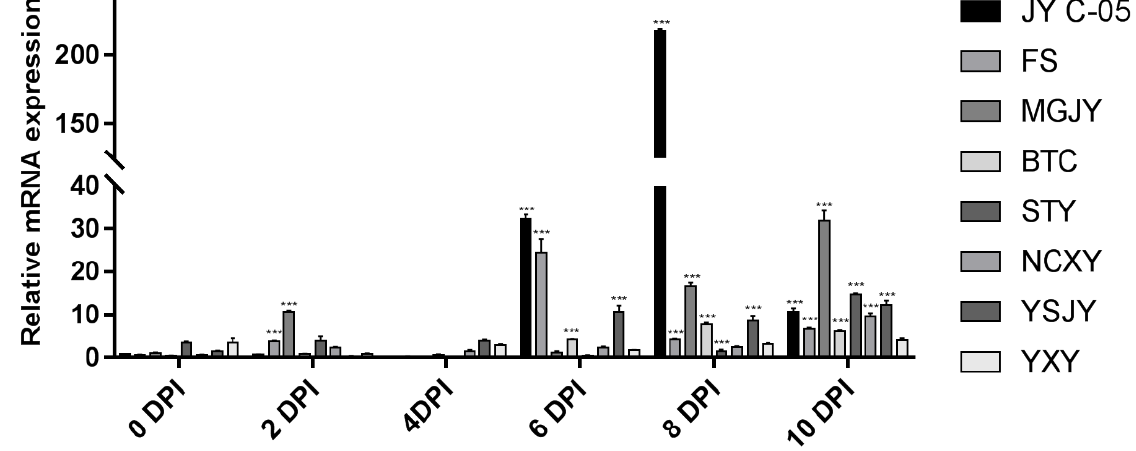
Figure 2. Relative expression levels of BAK1 . *** indicate significant differences ( p < 0.05, respec- tively). BTC: ‘Bingtang’ sweet orange; STY: Pomelo; NCXY: Nanchuan citron; YSJY: Wild citron; YXY: Round citron; MGJY: American citron; FS: Finger citron; JY C-05: Citron C-05.